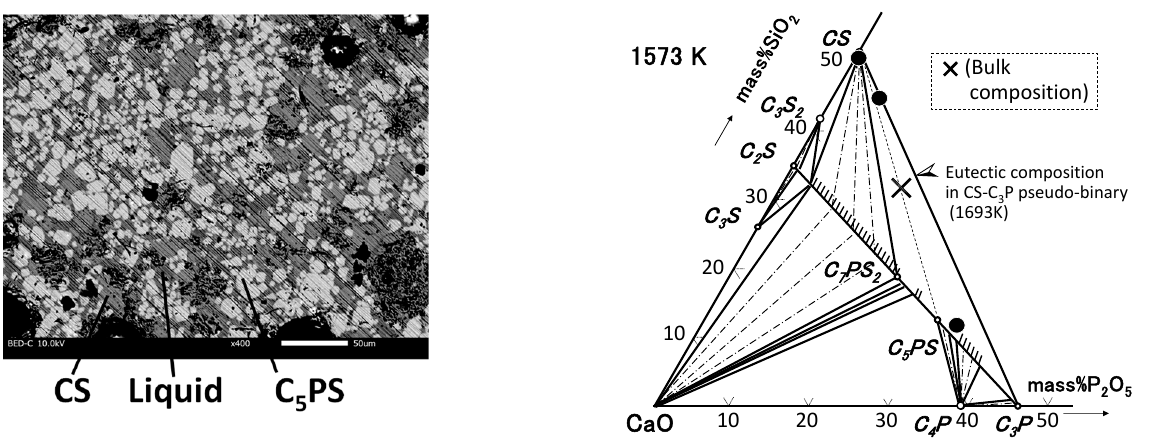
Figure 6. SEM image of M3-A2 (2mass% Al 2 O 3 ) ( left ) and phase composition projected on an iso-